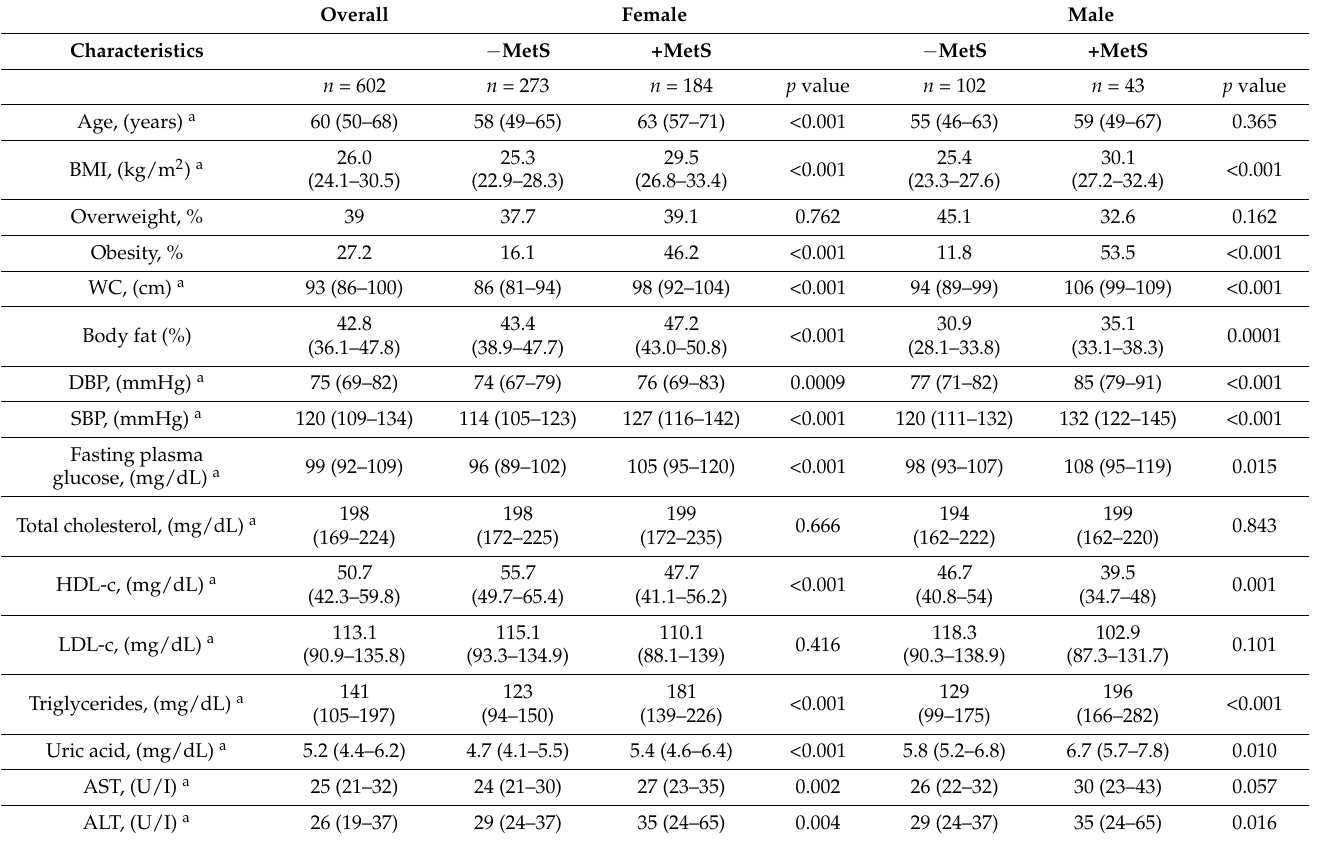
Table 1. Baseline characteristics of the study